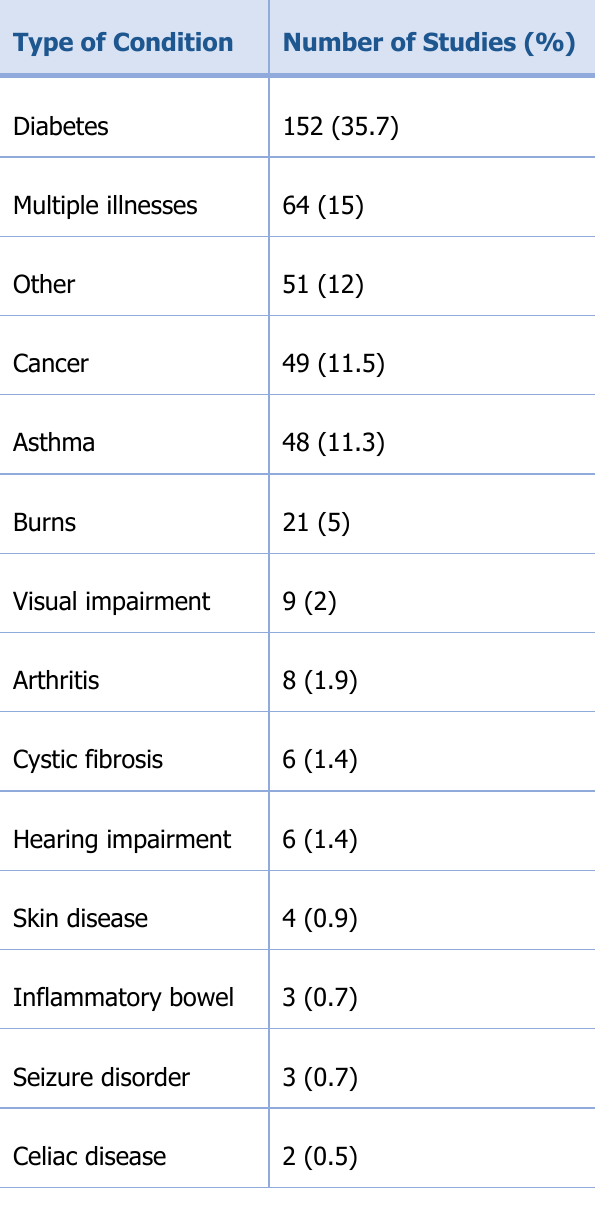
Table 3. Number of Studies on Camps that Address Identified